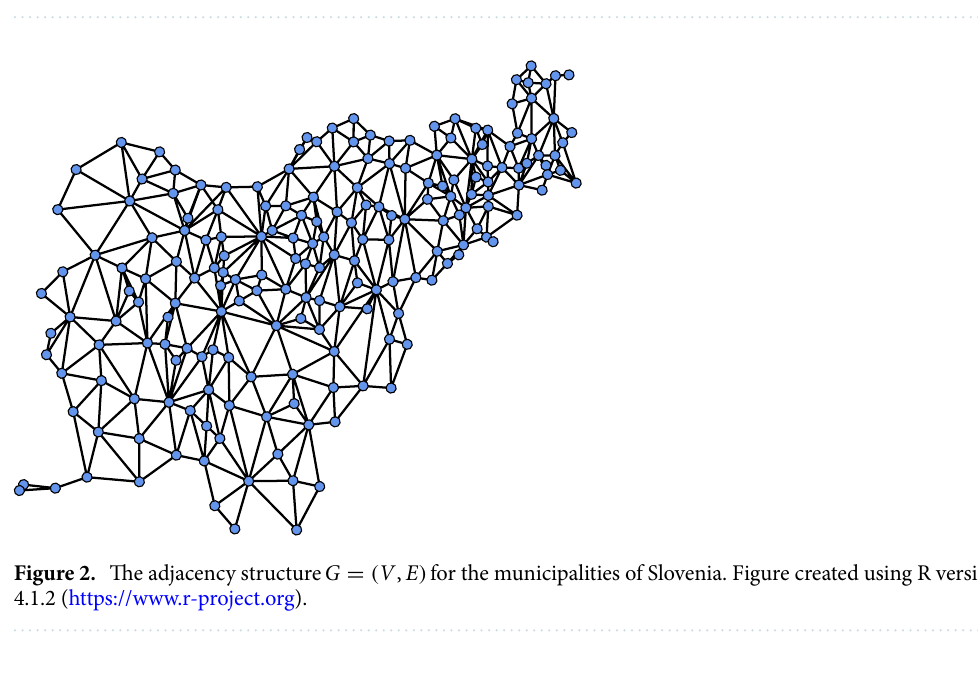
Figure 1. Stomach cancer incidence and socioeconomic status for the municipalities of Slovenia. Figure created using R version 4.1.2 (https:// www.r- proje ct. org).